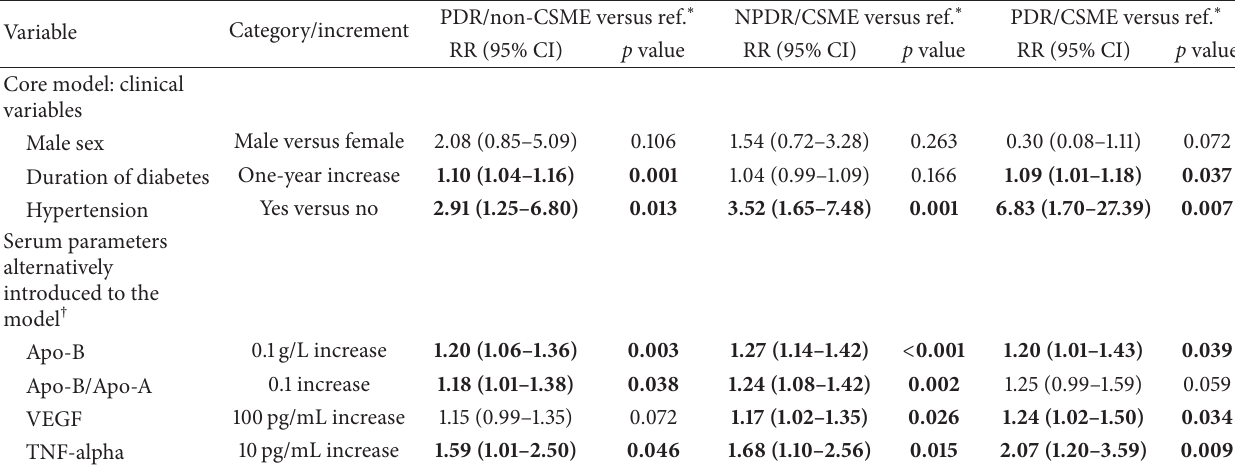
Table 3: Results of the multivariate multinomial logistic regression analysis. Bold cells denote statistically significant